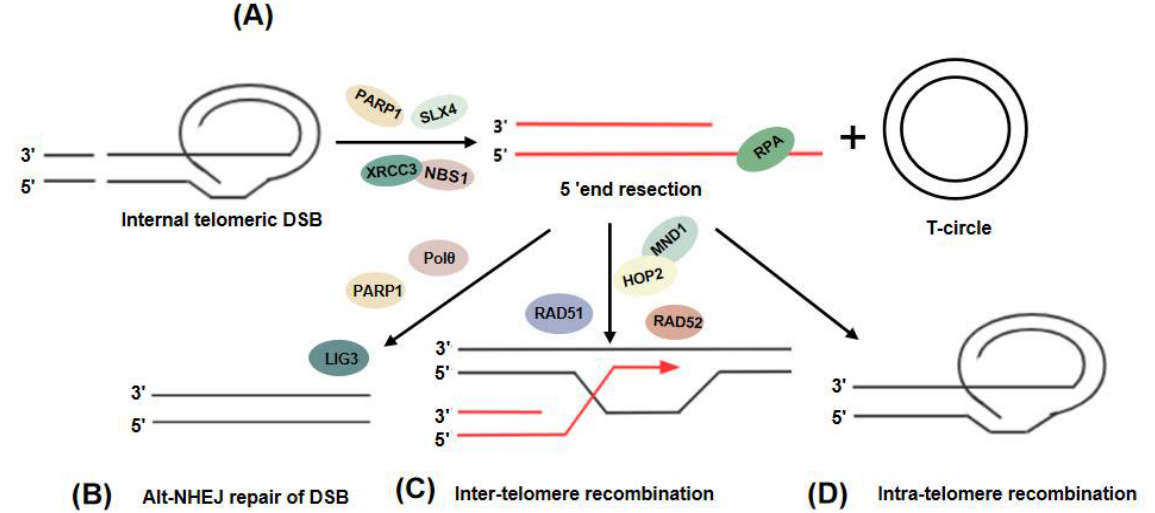
Figure 3. Internal telomeric double-strand breaks (DSBs) result in intratelomere recombination and the creation of T-circles in ALT cells. ( A ) Internal telomeric DSB recruitment of nucleases results in 5′ end cleavage and the creation of a T-circle. ( B ) Alternative nonhomologous end joining (Alt-NHEJ) repair of DSBs. ( C , D ) The 3′ overhang allows intertelomere recombination and intratelomere recombination.